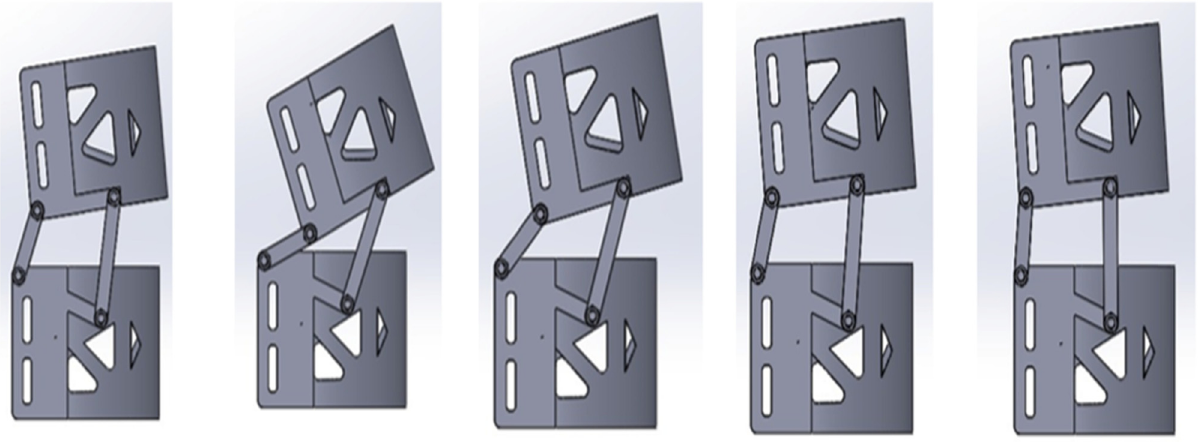
Figure 7: Model and simulation of the proposed LLE design in SolidWorks.